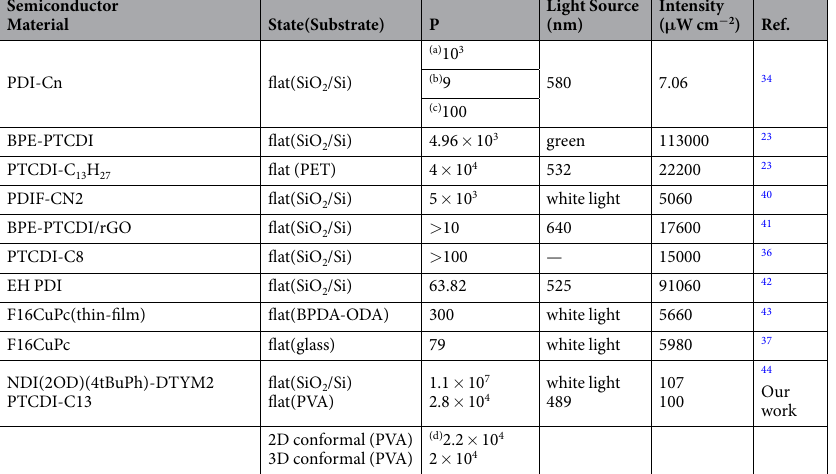
Table 1. Summary of performance of n -type organic phototransistor. (a) Thin film, (b) multifib, (c) monofib, (d) average value at different bending radius 48–51